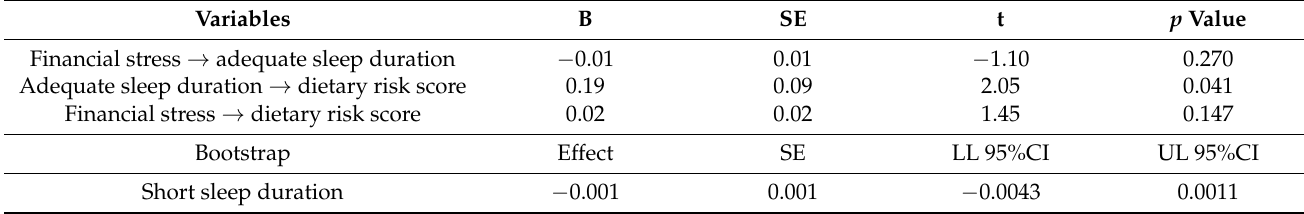
Table 9. Model 4 Mediation Analysis of Students Meeting the Minimum Sleep